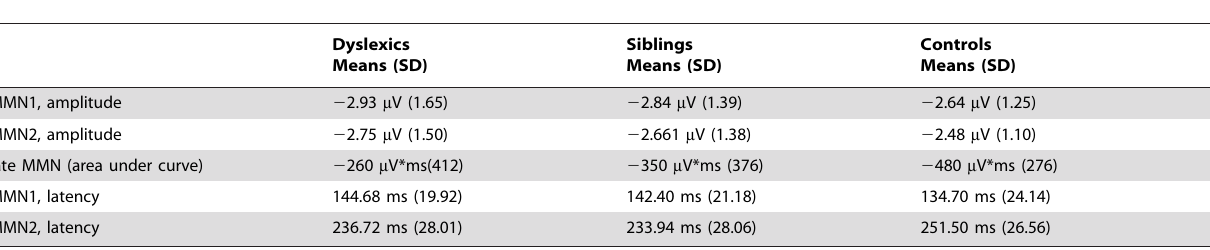
Table 2. Means and standard deviations of the MMN peak amplitudes, areas and latencies.